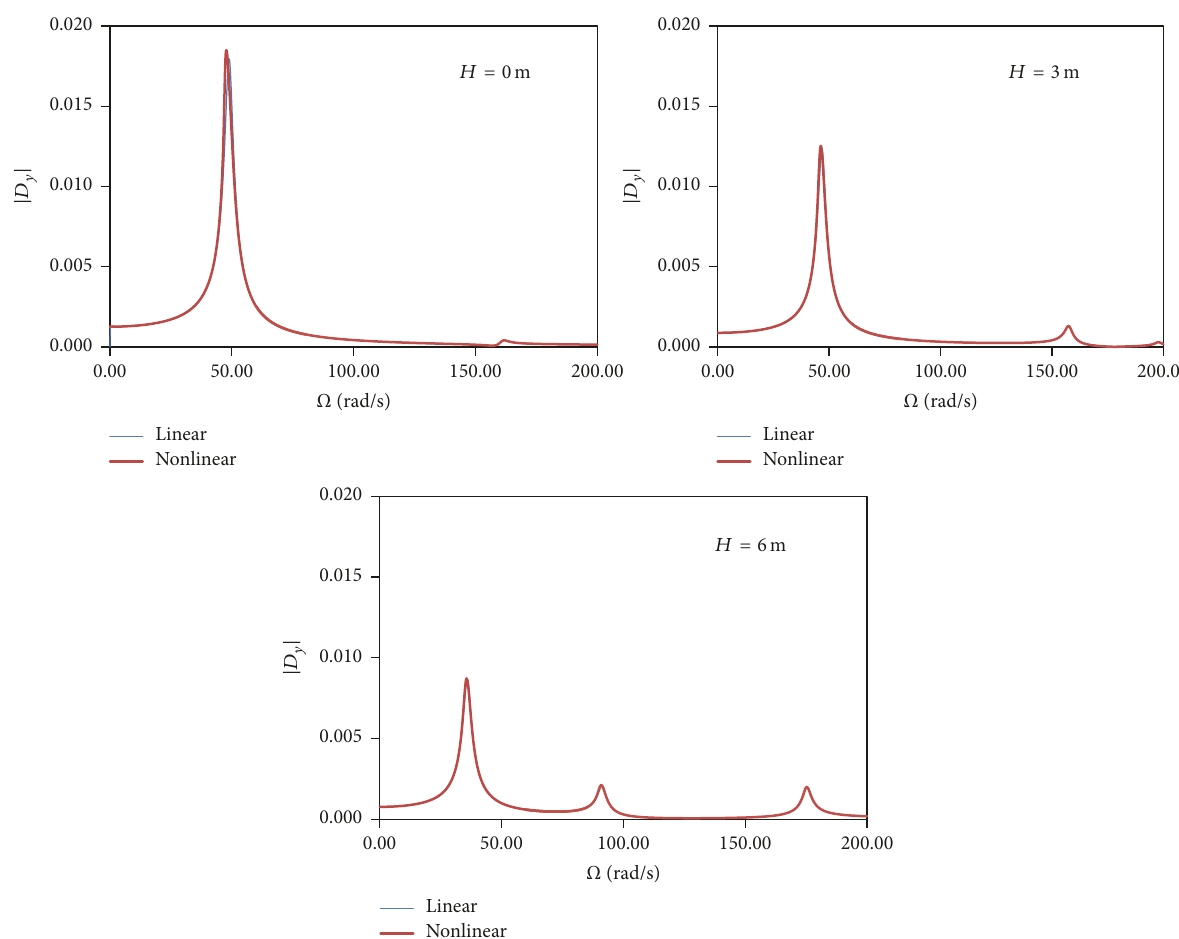
Figure 7: Variation of the norm of the vertical vibration amplitude at the roof top as a function of the excitation frequency for a vertical base excitation and three values of the roof height 𝐻 . 𝐴 𝑦 = 0.96𝑔 .